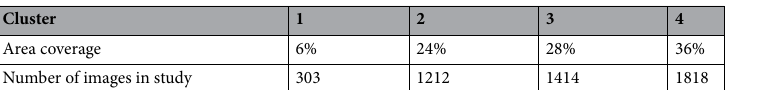
(Table 2). Detection and taxonomic classification of megafauna individuals from seabed images was conducted in